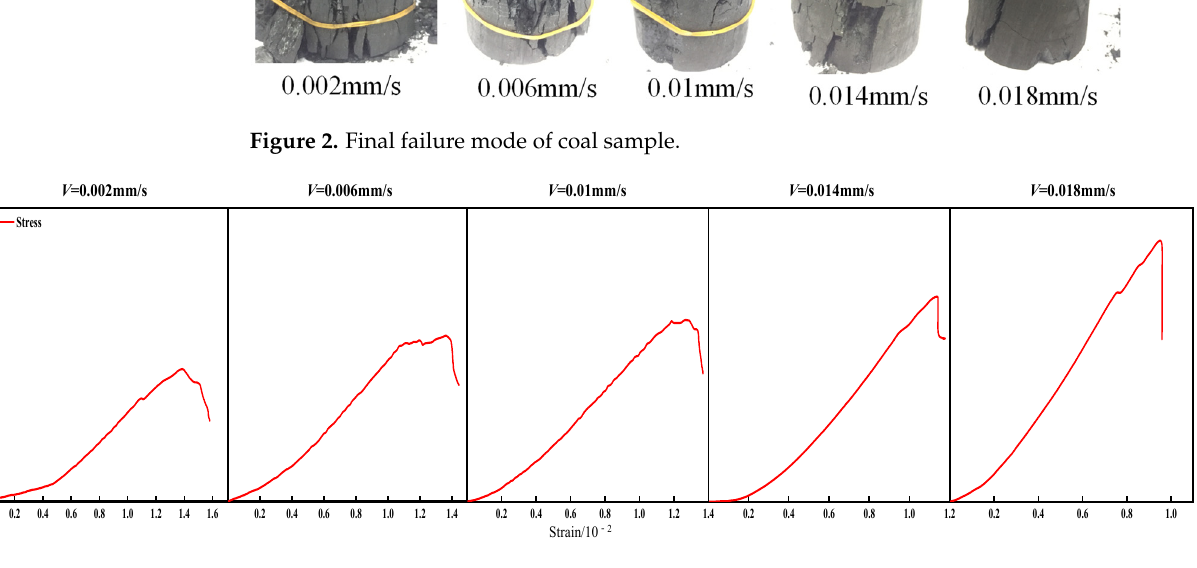
Figure 3. Stress–strain curve.